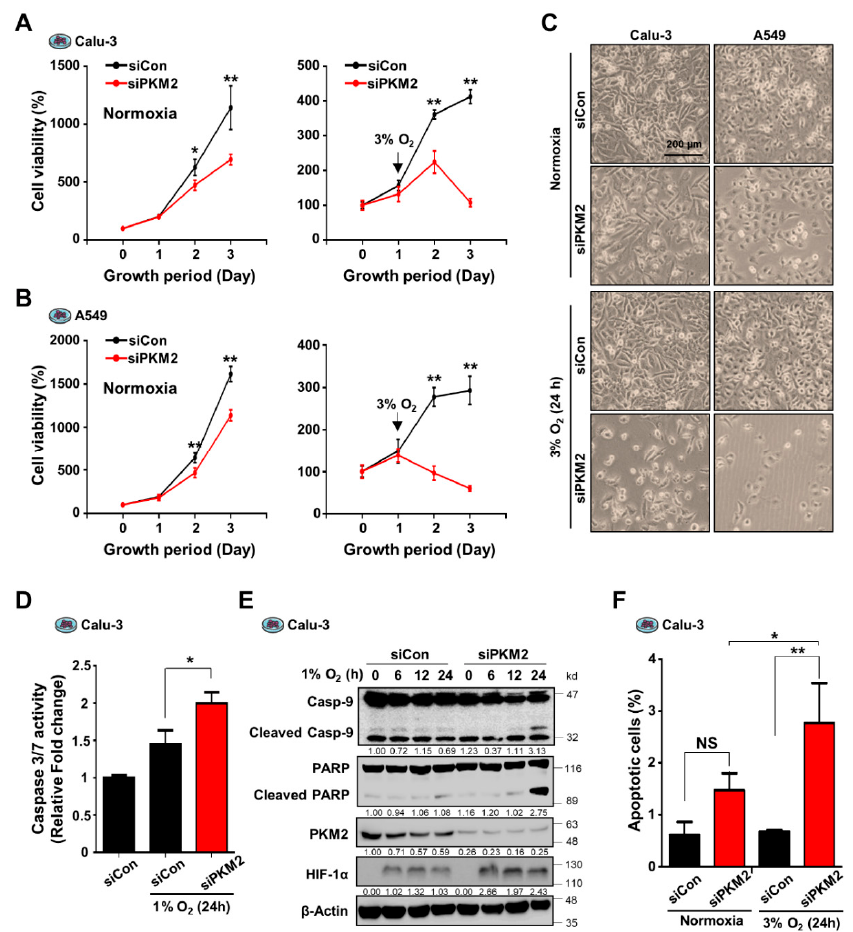
Figure 1. PKM2 is an important regulator of hypoxia-induced apoptosis in lung cancer cells. ( A , B ) Cell viability of ( A ) Calu-3 and ( B ) A549 cells transfected with PKM2 siRNA (siPKM2) or Negative Control siRNA (siCon). (Left) Following exposure to normoxic conditions for the indicated time, cells were incubated with CellTiter-Blue® for 2 h. Fluorescence was measured at 530 nm Ex/590 nm Em. (Right) Following incubation in 3% O 2 for 24 and 48 h, cell numbers were determined by automated cell counter after staining with Trypan blue ( n = 3). ( C ) Representative images of cells following treatment with PKM2 siRNA captured under an Olympus microscope IX71 with fluorescence and phase contrast. ( D ) Caspase 3/7 activity in Calu-3 cells treated with PKM2 siRNA or Control siRNA. ( E ) Analysis of apoptosis-associated proteins (cleaved Casp-9, cleaved PARP) in Calu-3 cells transfected with PKM2 siRNA or Control siRNA, under hypoxic (1% O 2 ) conditions for indicated times. HIF-1 α served as an indicator of hypoxic conditions. β -Actin was used as the loading control. ( F ) FACS analysis of Annexin V-stained Calu-3 cells transfected with siCon or siPKM2 ( n = 3). All values of graphs were presented as mean ± SD. Statistical significance was measured using (A, B, D) one- or (F) two-way ANOVA with the Tukey post hoc test. * p < 0.05, ** p < 0.01, and NS, statistically not